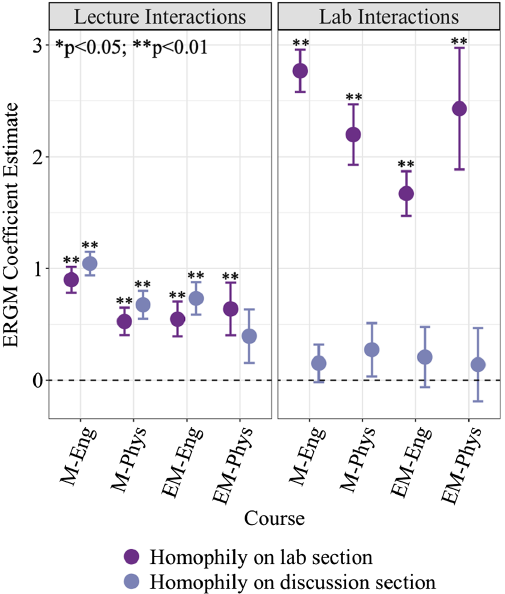
FIG. 4. Plot of ERGM coefficients for the homophily on lab section and homophily on discussion section variables. A more positive (negative) coefficient estimate indicates that more (fewer) edges occur between students in the same section. Error bars indicate the standard error for each estimate and asterisks indicate statistical significance.